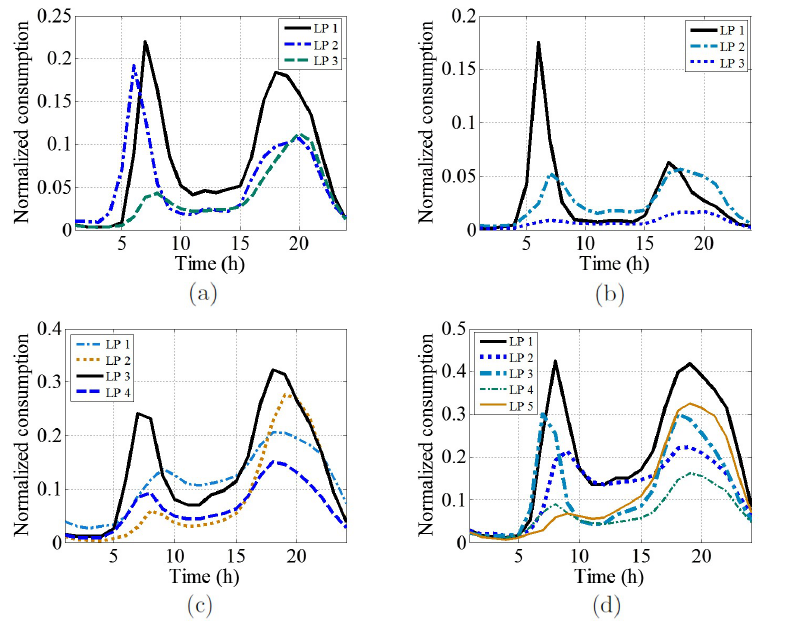
Figure 15. Seasonal representative of normalized load profiles (LP) for: ( a ) spring; ( b ) summer; ( c ) autumn; ( d )